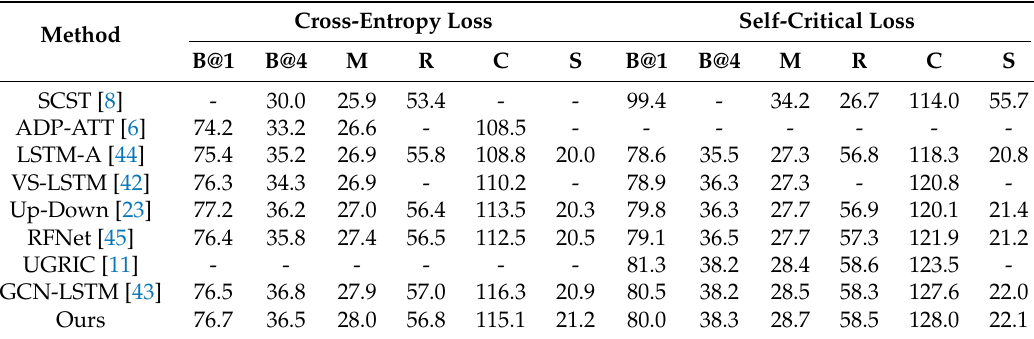
Table 1. Performance of our model and several state-of-the-art single models evaluated on MSCOCO “Karpathy” offline test split.